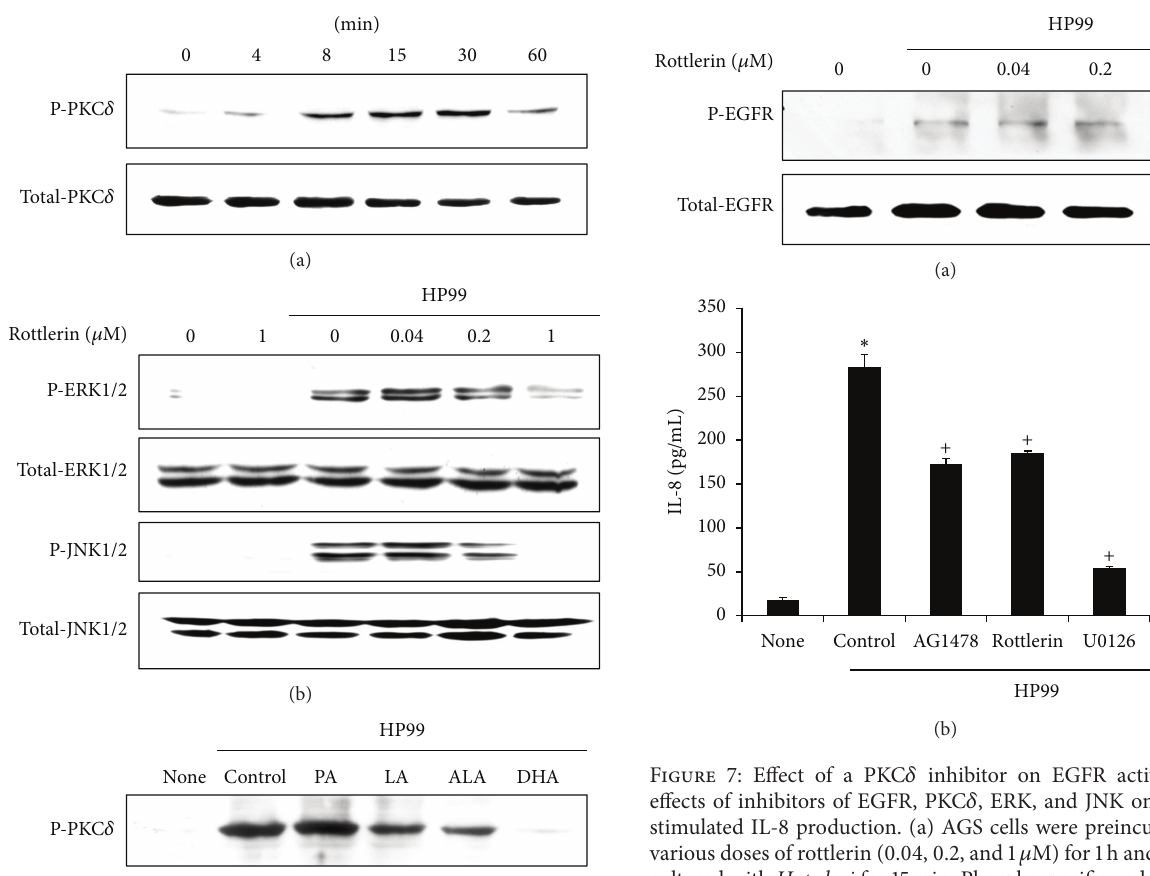
study, 𝜔 -3 fatty acids exert anti-inflammatory effects